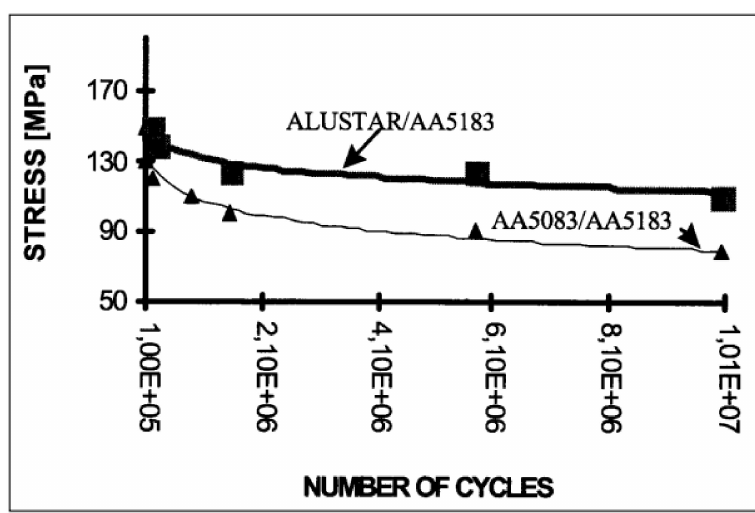
Figure 3. Wöhler diagram for AA5059 and AA5083 alloys